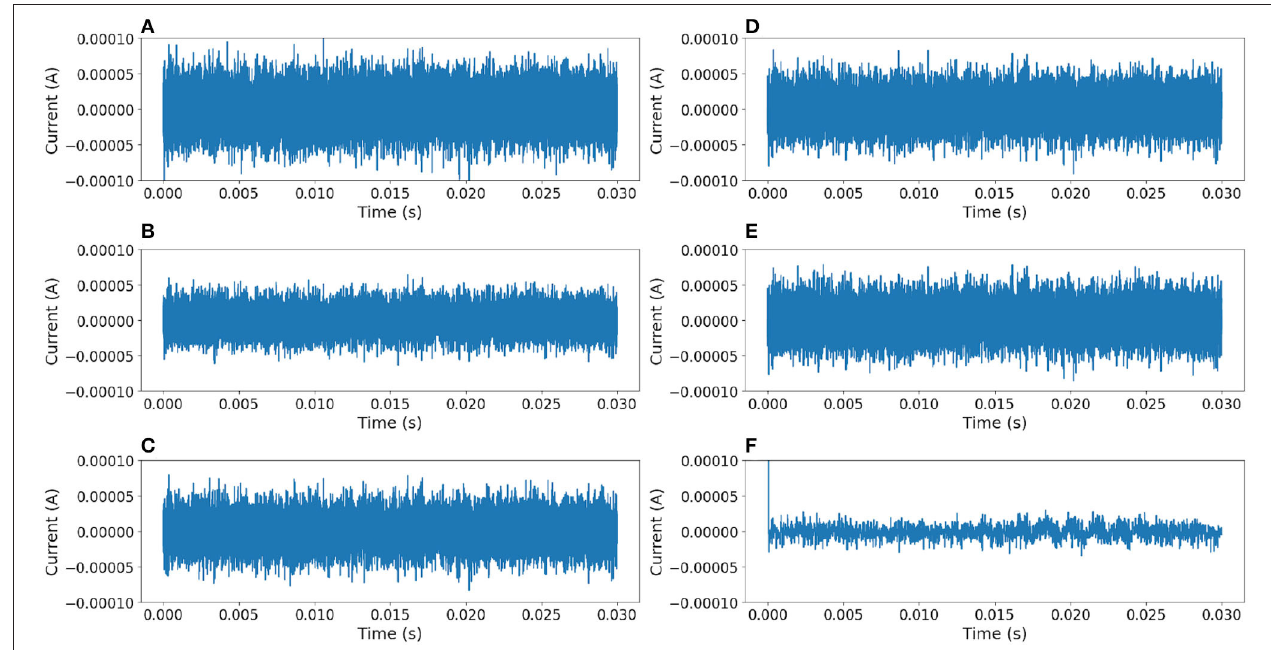
FIGURE 11 | Comparison of error between outputs of different filters (additive white noise) and the original signal. The ideal error signal must be 0 at any time. (A) Median filter. (B) 3rd-order Chebyshev type 1 filter. (C) 3rd-order Chebyshev type 2 filter. (D) 3rd-order Butterworth filter. (E) 3rd-order Elliptic filter. (F) Neural filter proposed.